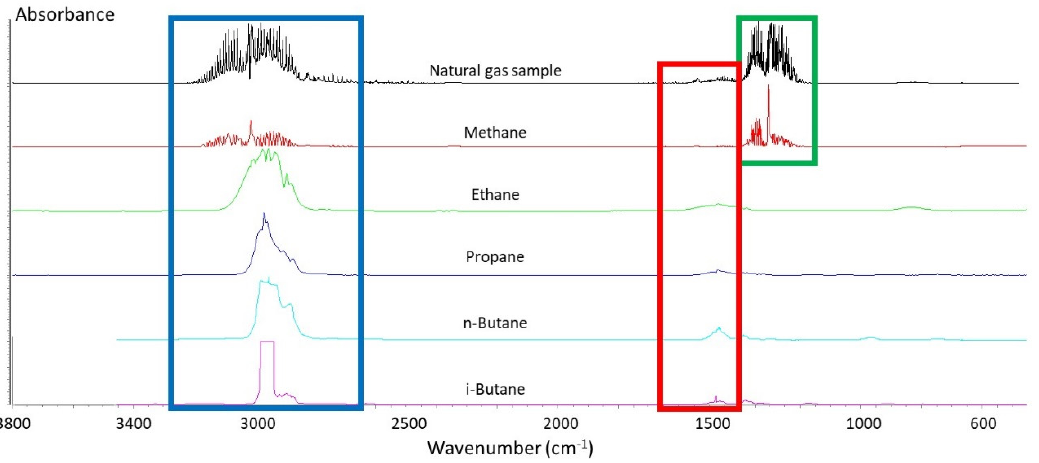
Figure 8. Comparison between the spectra of regasified LNG and its main aliphatic components (as stated in Reference